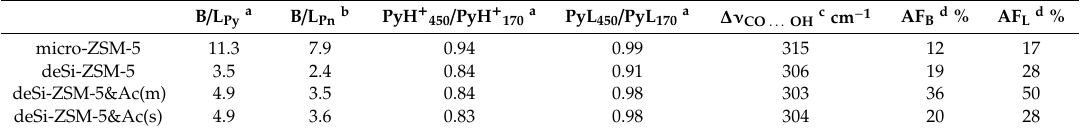
Table 2. Acid sites properties derived from FT-IR studies of Py, Pn and CO sorption.